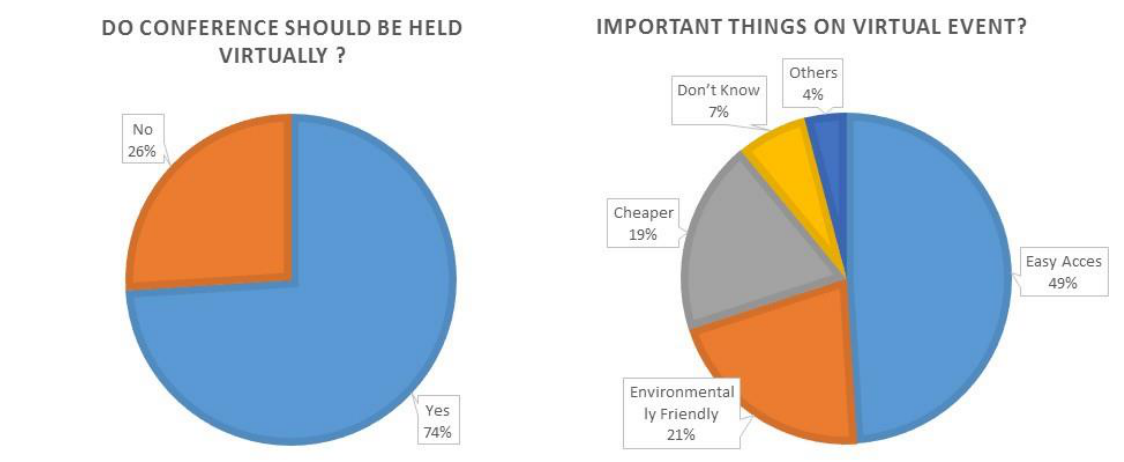
Figure.3 Survey Results That Virtual Events More